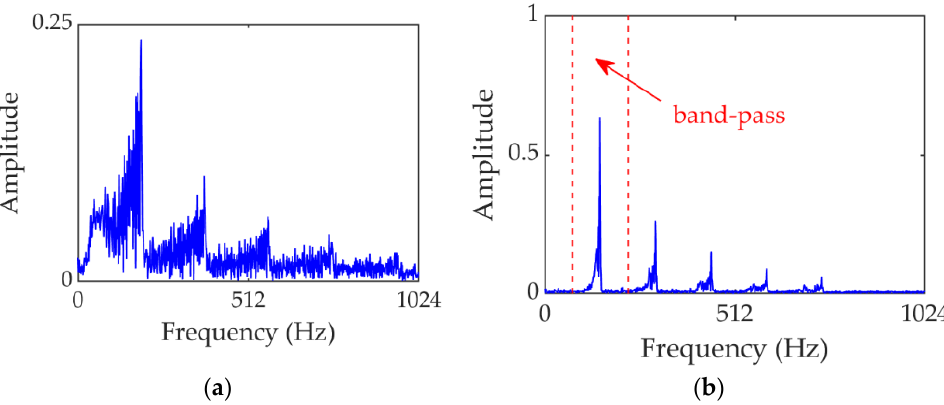
Figure 7. ( a ) The amplitude spectrum of the signal before resampling; ( b ) the amplitude spectrum of the signal after resampling.